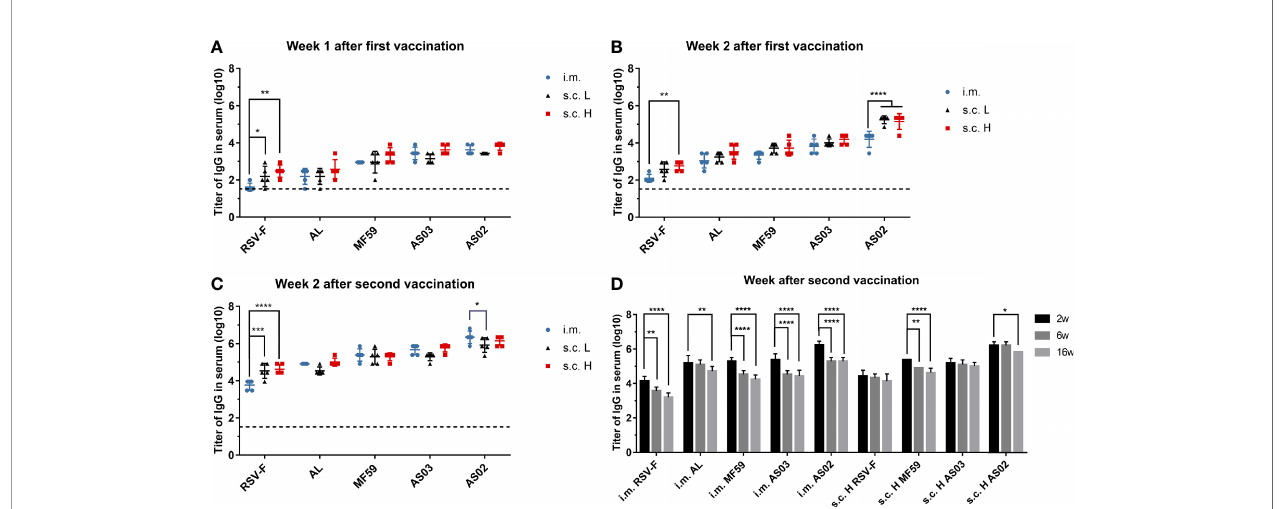
FIGURE 2 | RSV-F-speci fi c IgG titers in sera of mice intramuscularly or subcutaneously immunized with various RSV-F vaccines with or without adjuvants. The sera of mice in each group were detected at weeks 1 (A) , 2 (B) after the fi rst vaccination, and weeks 2 (C) , 6 and 16 (D) after boosting by ELISA, respectively. Each data point represents an individual animal. Results were shown as mean ± SD of antibody titers calculated from fi ve mice per group. The limit of detection (LOD) was 2. The dashed line with a value of 1.52 represented the results of PBS group. Data of panel (A – D) were collected from two independent experiments, respectively.